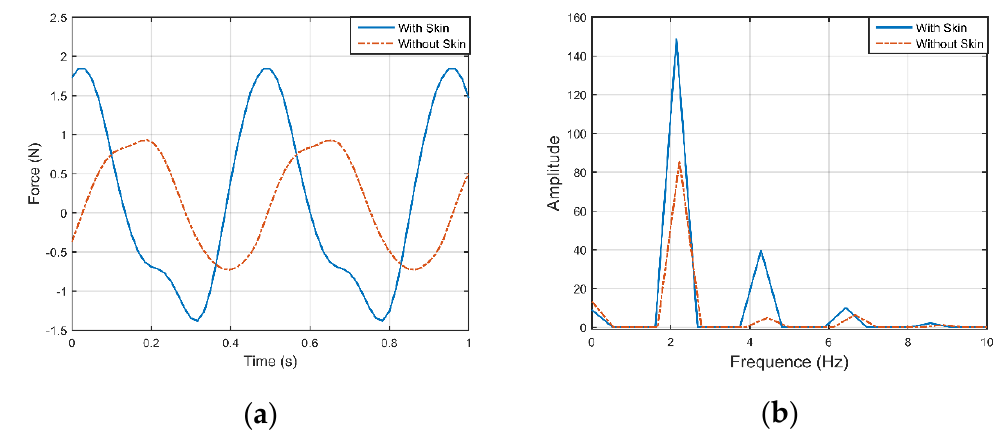
Figure 11. Measured force with ( a ) and without skin; ( b ) transformed data in the frequency domain.